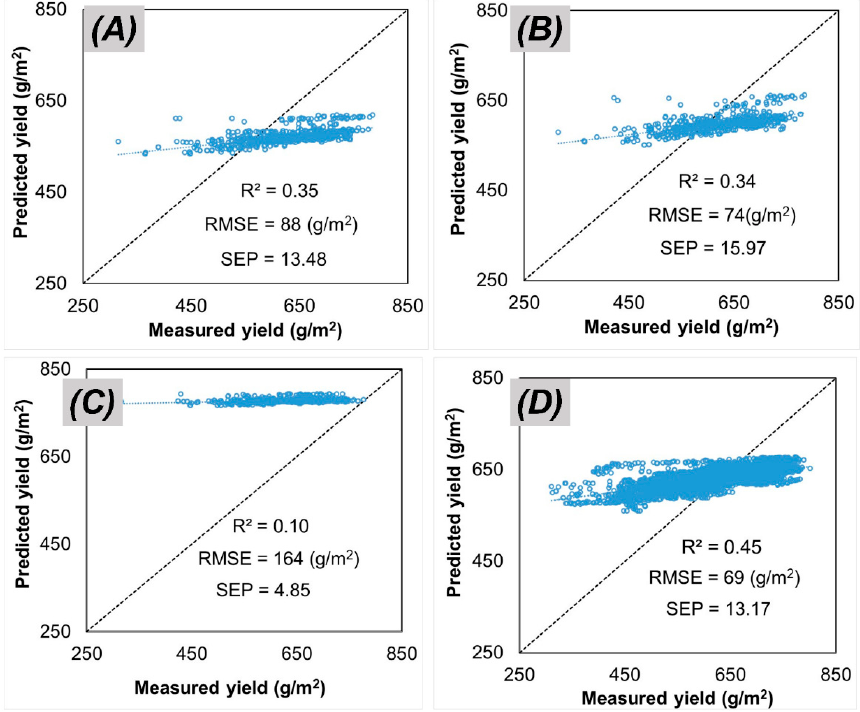
Figure 7. Comparison of measured and predicted wheat yield. The SAFY model used different remote sensing-based LAI estimations for yield prediction. Yield predicted using ( A ) S2-LAI; ( B ) LAI derived from S2 MSAVI and S2-LAI model; ( C ) LAI derived from S2 MSAVI and field-measured LAI model; ( D ) LAI derived from PS-S2 fused image MSAVI and S2-LAI model. R 2 denotes the coefficient of determination, RMSE denotes root mean square error, and SEP denotes the standard error of prediction.